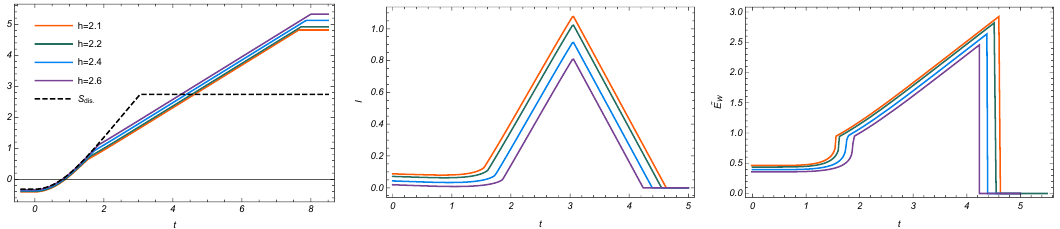
Figure 11 . Left : the HEE for connected and disconnected con(cid:12)guration for di(cid:11)erent values of the separation between subregions. The connected con(cid:12)guration is always favored for any boundary time. Middle : the HMI as a function of time which is positive during the entire evolution. Right : the EWCS as a function of boundary time which saturates to a (cid:12)nite value. Here we have set ‘ = 1 : 18 and d = 3.